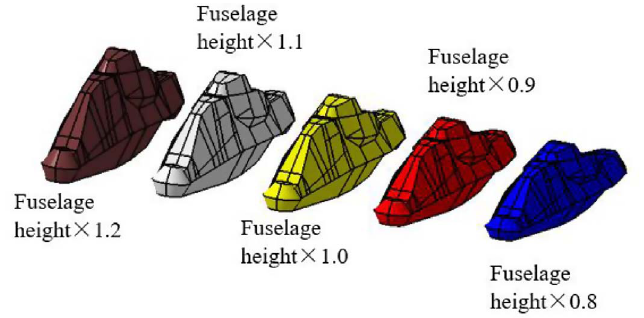
Figure 18. Fuselages with different height ratios.